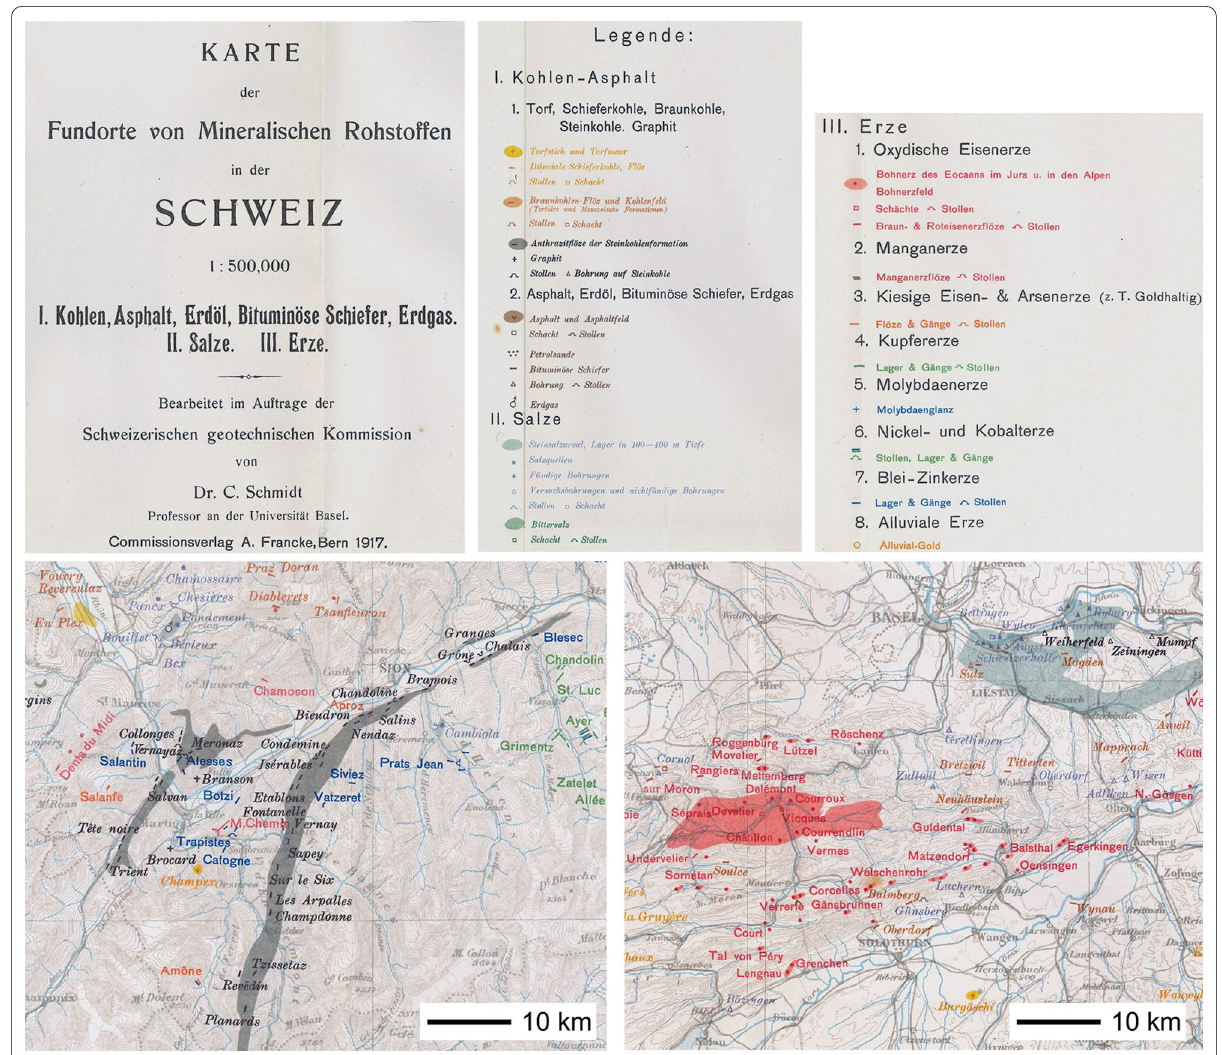
Fig. 8 Extracts of the georesources map (1:500 ′ 000) by Schmidt (1917). top : extracts from the map header and the legend. The displayed raw materials are sorted in groups: (I.1) peat, coal, graphite, (I.2) asphalt, oil, bituminous schists, gas, (II) salt, (III) ores (Fe, Mn, Cu, Mo, Ni, Co, Pb, Zn, Au). bottom left: extract of the lower Valais area (SW Switzerland) illustrating the anthracite/hard occurrences in the Permian and Carboniferous units in the Zone Houillère and the Aiguilles Rouges Massif (dark grey polygons). bottom right : extract of the area between Basel and Solothurn (central northern Switzerland). The red polygon marks an area with high concentration of Eocene pisolithic iron ore deposits (“Bohnerz”) in the Jura fold-and-thrust belt south of Delémont. The pale grey polygon illustrates the belt of halite deposits occurring in the Triassic units southwest of Basel at ca. 100–400 m depth. See the full extent and resolution of this map in Additional file 3. For location of the two map extracts see Fig.